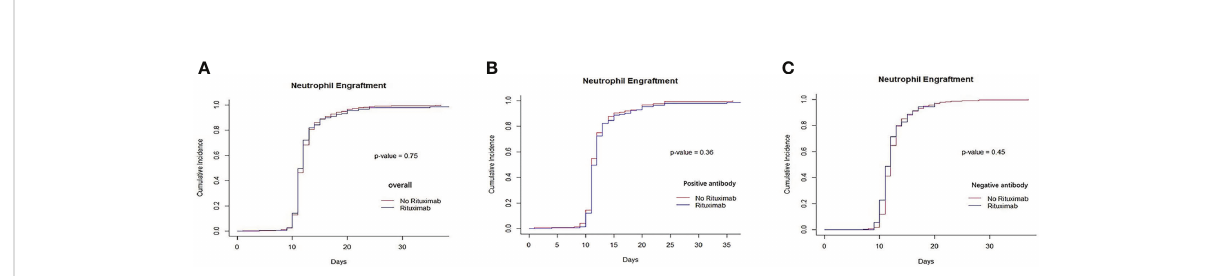
FIGURE 1 Recovery of neutrophils between rituximab and non-rituximab groups. (A) The cumulative incidence of neutrophil engraftment in entire patient cohort. There was no difference in the cumulative incidence of neutrophil engraftment rituximab and non- rituximab groups in entire patient cohort (P= 0.75). (B) The cumulative incidence of neutrophil engraftment in positive anti-HLA antibody group. There was no difference in the cumulative incidence of neutrophil engraftment between 2 groups in positive antibody group (P= 0.36). (C) The cumulative incidence of neutrophil engraftment in patients with negative anti-HLA antibody group. There was not different between 2 groups in the cumulative incidence of neutrophil engraftment in patients with negative anti- HLA antibody (P=